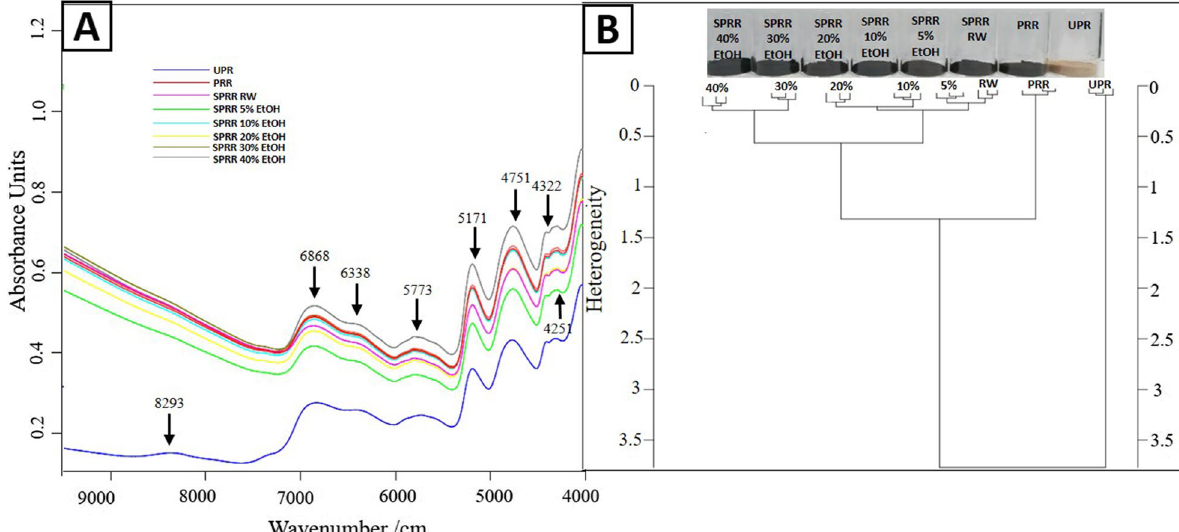
Fig. 6 The fourier transform near-infrared (FT-NIR) spectroscopy of characterization all R. glutinosa samples. a FT-NIR spectra of analysed R. glutinosa samples. b Dendogram of analysed FT-NIR showing the heterogeneity of all R. glutinosa samples. * UPR Unprocessed R. glutinosa , PRR , Processed R. glutinosa , SPR , Supplemented Processed R. glutinosa , RW Rice